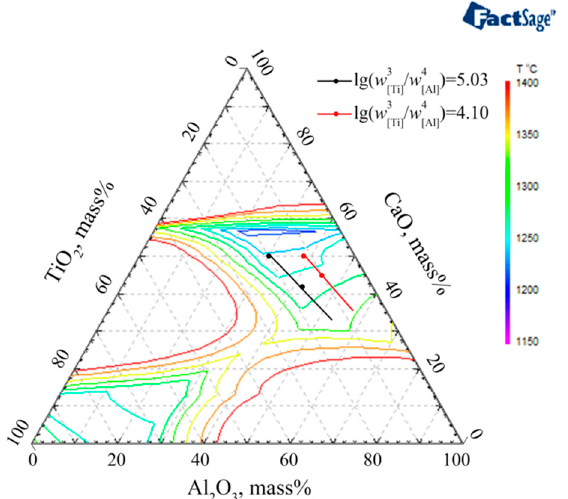
(cid:2871) ) in / a 2 TiO 2 Al 2 O 3 (cid:3118)